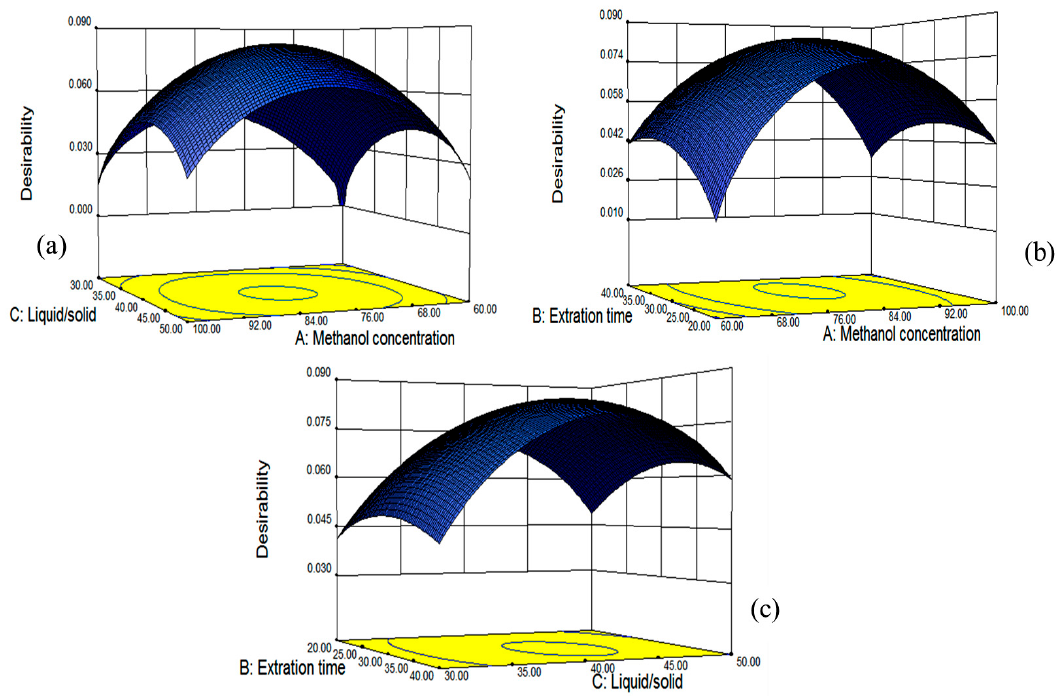
Figure 7. The three-dimensional plots showing the correlative effects of methanol concentration ( a ); extraction time ( b ) and the liquid/solid ratio ( c ) on the overall desirability. Table 3. Predicted and experimental values of the responses obtained under the optimal extraction conditions. RE, relative error.